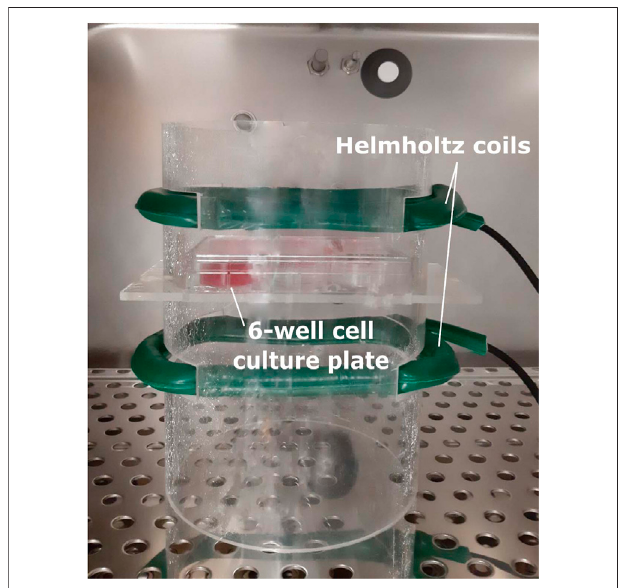
FIGURE 1 | Electromagnetic bioreactor setup with culture plate. The culture plate is located between the Helmholtz coils, which are creating induced currents in the